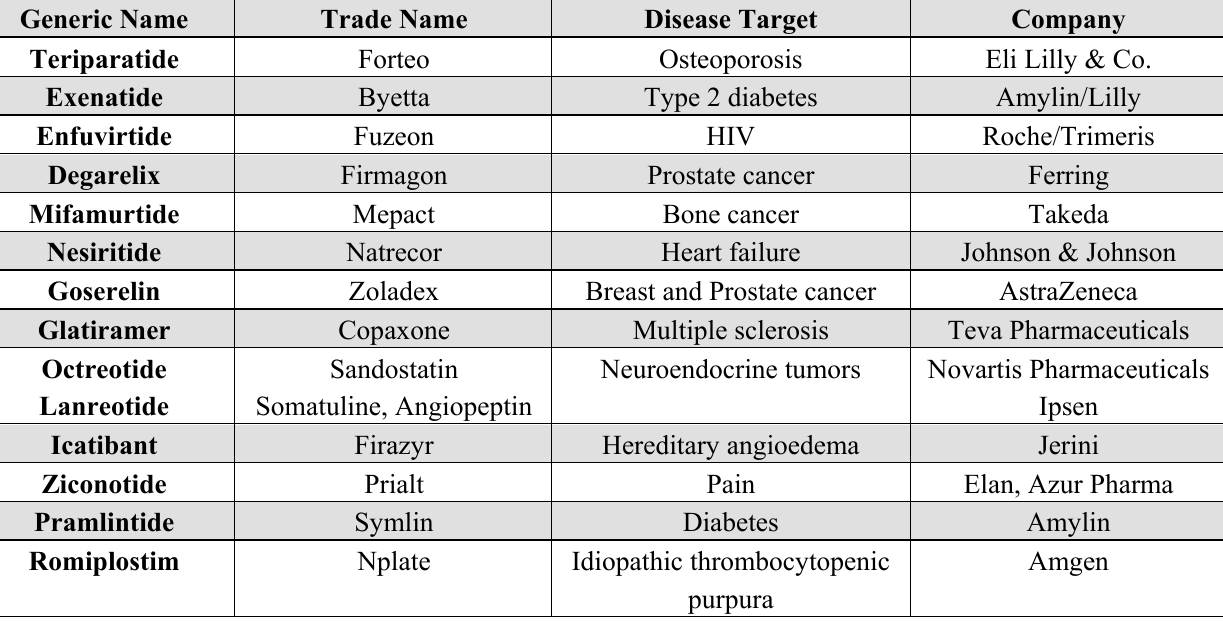
Table 3. Examples of peptide based drugs available on the